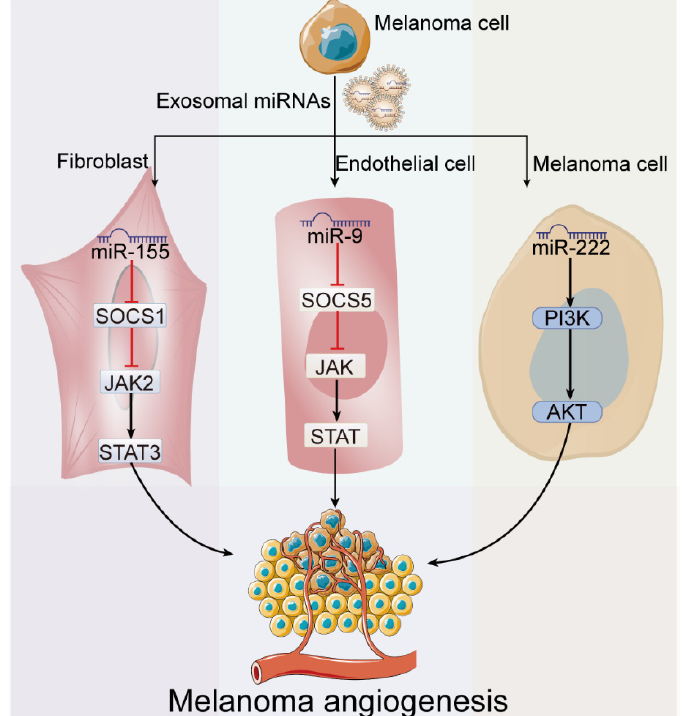
Figure 5. Roles of exosome-derived miRNAs in melanoma angiogenesis. On the one side, exosome- derived miRNAs regulate melanoma microenvironment to facilitate angiogenesis through working on fibroblasts or melanoma cells. On the other sides, exosomal miRNAs from melanoma can be uptaken directly by endothelial cells to induce angiogenesis.